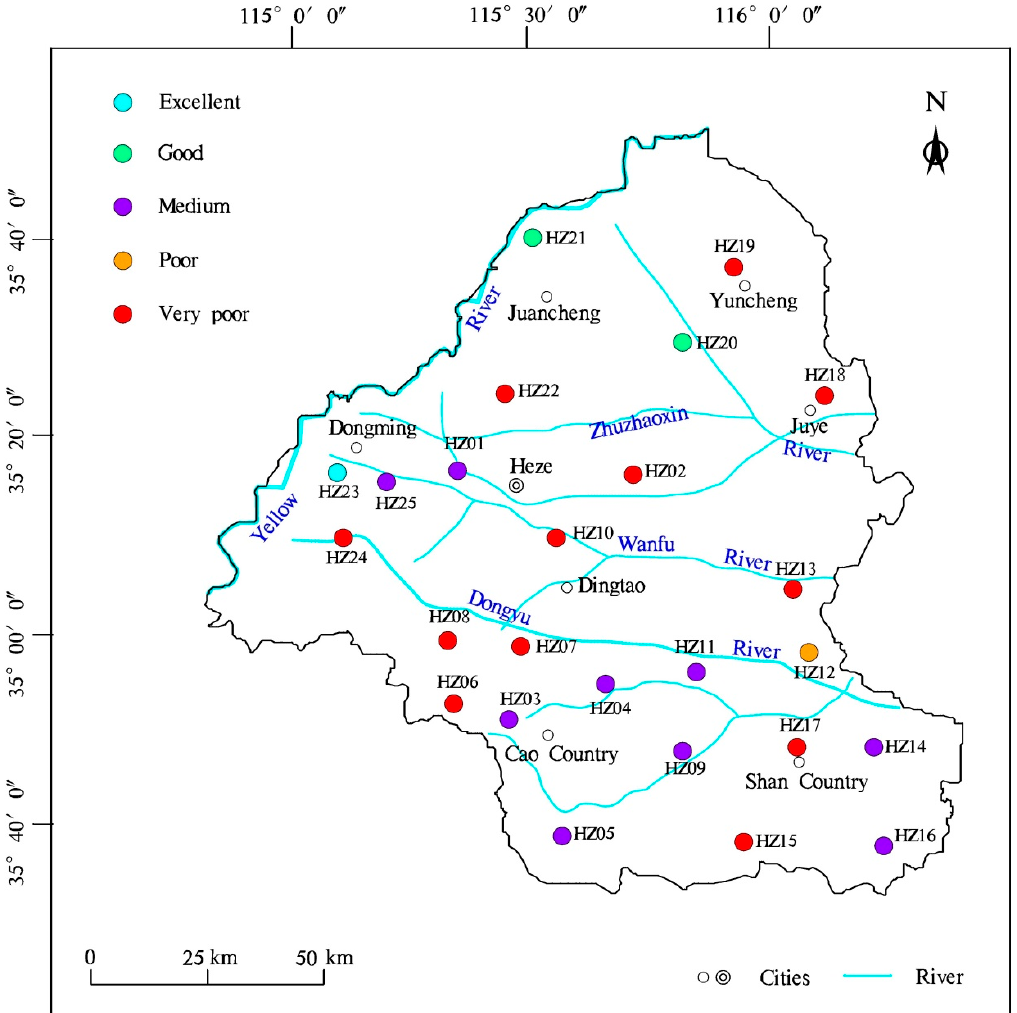
Figure 9. Results of groundwater quality for drinking uses in 2016.